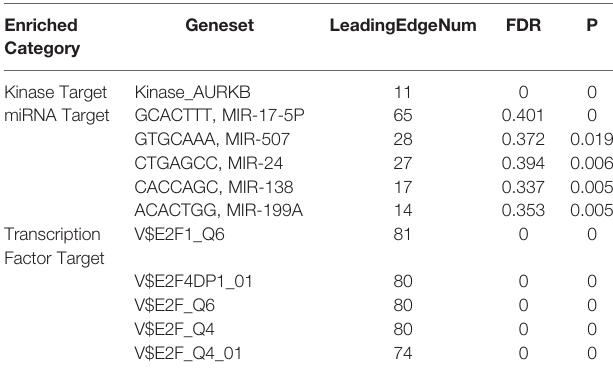
TABLE 2 | The Kinase, miRNA and transcription factor-target networks of BIRC5 in LUAD